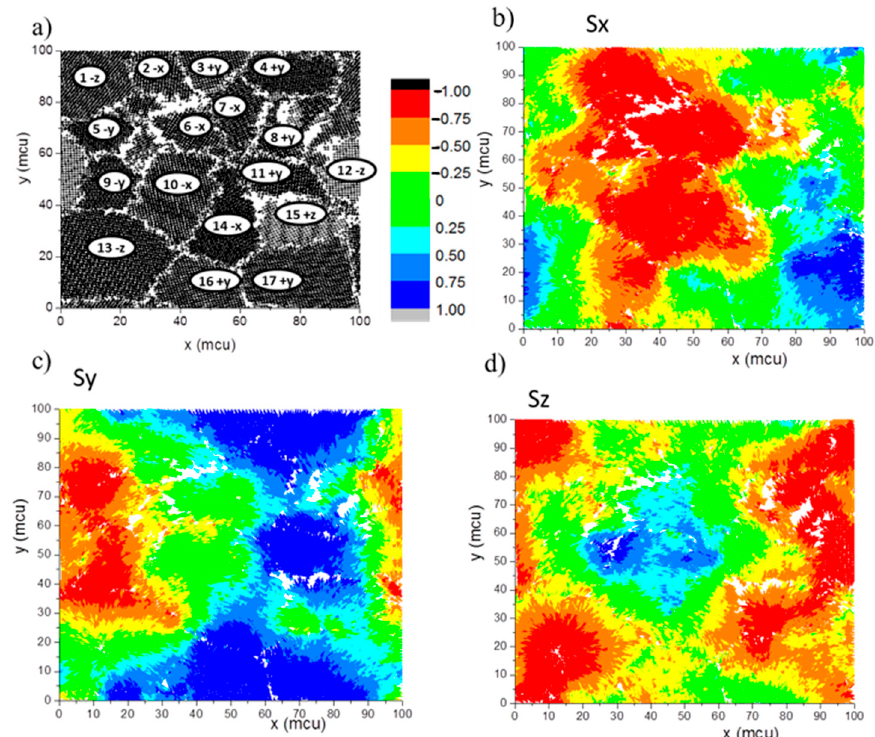
Figure 6. Middle plane representation at a thickness of 20 muc of ( a ) structural distribution, and ( b – d ) colour map of a final state for S x , S y and S z , respectively. The grains were labelled with their number and preferential spin orientation in ( a ). The atoms in the grain boundaries have been suppressed for visualization purposes.